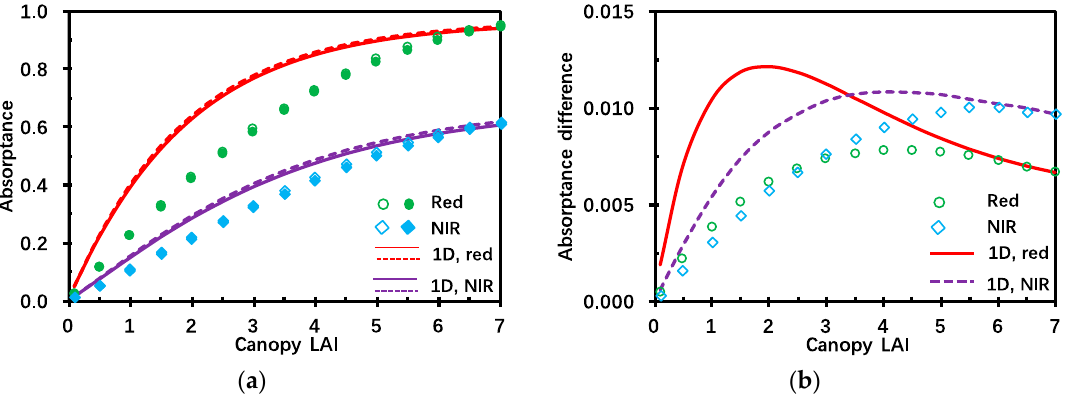
Figure 6. ( a ) Mean canopy absorptance at red and NIR bands as a function of canopy LAI. Solid symbols and lines correspond to the mean canopy absorptance when leaf specular reflection is accounted for, whereas hollow symbols and dashed lines denote that when leaves are bi-Lambertian scatters. ( b ) Difference between mean canopy absorptance when leaf specular reflection is neglected (i.e., leaves are bi-Lambertian scatters) and when it is accounted for at red and NIR bands. The canopy is bounded from below by a non-reflecting background. Plant LAI is constant and equals 7.0. Ground cover varies with canopy LAI as LAI/7.0. Other parameters are the same as in Figure 4.